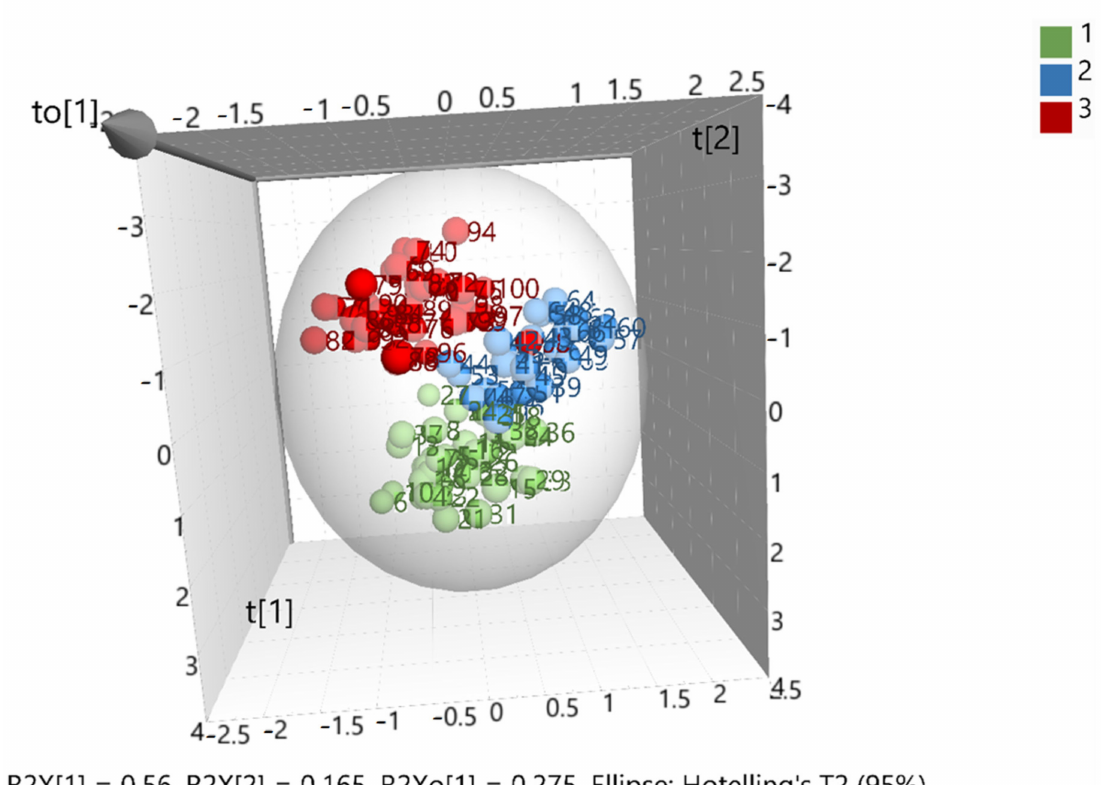
Figure 4. Three-dimensional illustration of the score scatter plot in Figure 3 where 1 = Maurolia (Messinia), 2 = Lianolia Kerkyras (Preveza), and 3 = Koroneiki